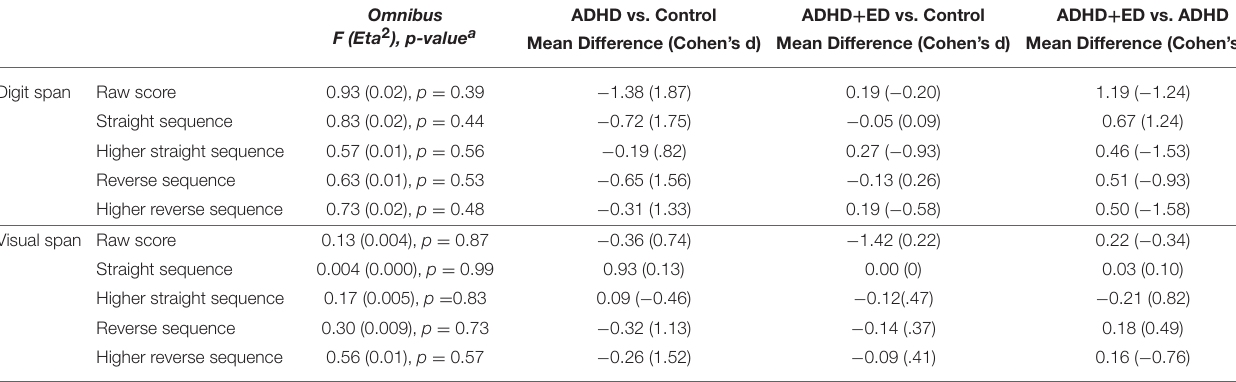
Omnibus ADHD vs. Control ADHD + ED vs. Control F (Eta 2 ), p-value a